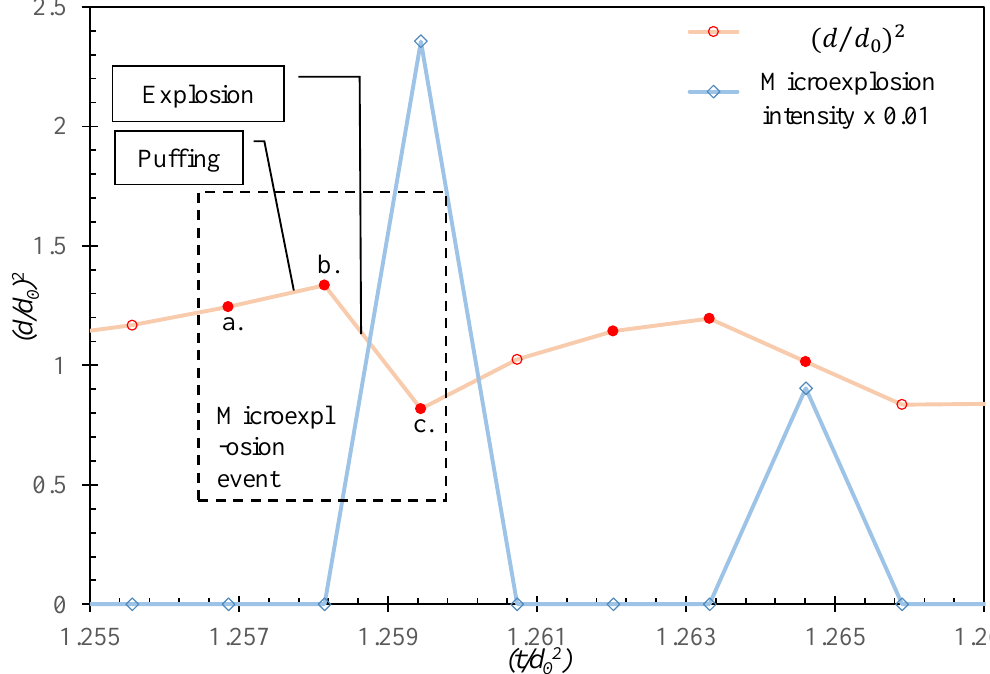
Figure 10. Microexplosion behavior in a Bakken crude droplet experiment, zoomed into the region from 𝑡 𝑑 02 ⁄ = 1.25 to 1.267 to show microexplosion characterization and intensity (scaled by a factor of 100 for easier representation). Solid red points correspond to the (𝑑 𝑑 0 ⁄ ) 2 plot points that characterize puffing and explosion behavior. A single microexplosion event progresses from a to b to c. Region a to b represents droplet puffing, marked by a sharp rise in normalized droplet area (𝑑 𝑑 0 ⁄ ) 2 , which is followed by an explosion from b to c, characterized by a sharp decrease in (𝑑 𝑑 0 ⁄ ) 2 .